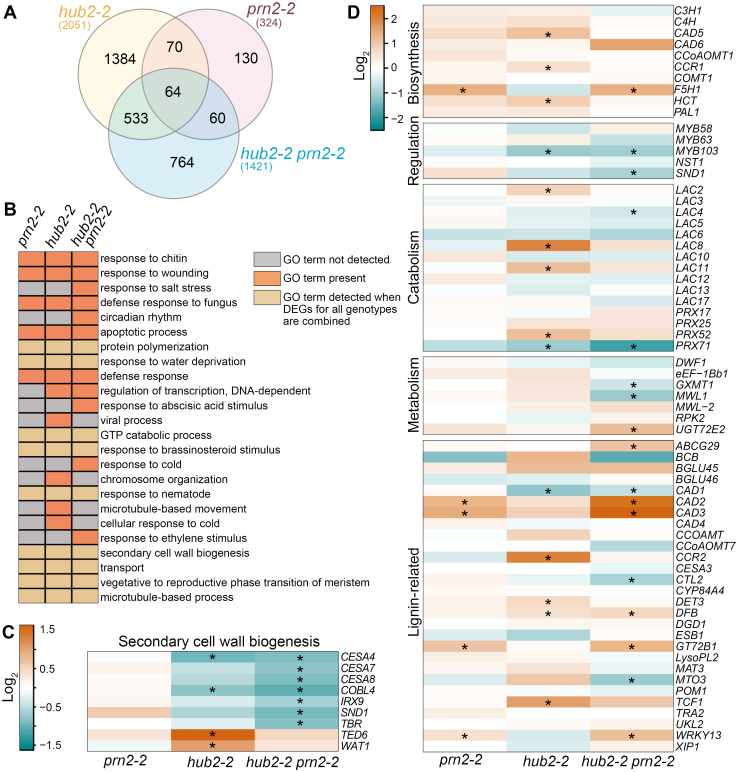
HUB2 and PRN2 regulate antagonistically the expression of F5H1. (A) Venn diagram showing the number of DEGs (differentially expressed genes) detected in an RNA-seq experiment in hub2-2, prn2-2, and hub2-2 prn2-2. The genes included in the analysis fulfil the criteria of |log2FC|>2 and a PAdj<0.05. For each genotype, three biological replicates were analysed, each consisting of a pool of five hypocotyls. The plants were grown under short-day (8/16 h) conditions for 7 weeks, followed by long-day (16/8 h) conditions for 4 weeks. (B) Enriched GO terms in all DEGs identified for each genotype. Enriched GO terms for DEGs in the individual mutants or DEGs combined for all mutants are indicated in orange and light brown, respectively. (C) Expression level of DEGs identified as part of the secondary cell wall biogenesis GO term (GO:0009834). (D) Expression level of all genes that are part of the lignin GO term (GO:0009809). Asterisks mark conditions in which gene expression is significantly different (following |log2FC|>2 and a PAdj<0.05) in the mutant compared with the wild type.